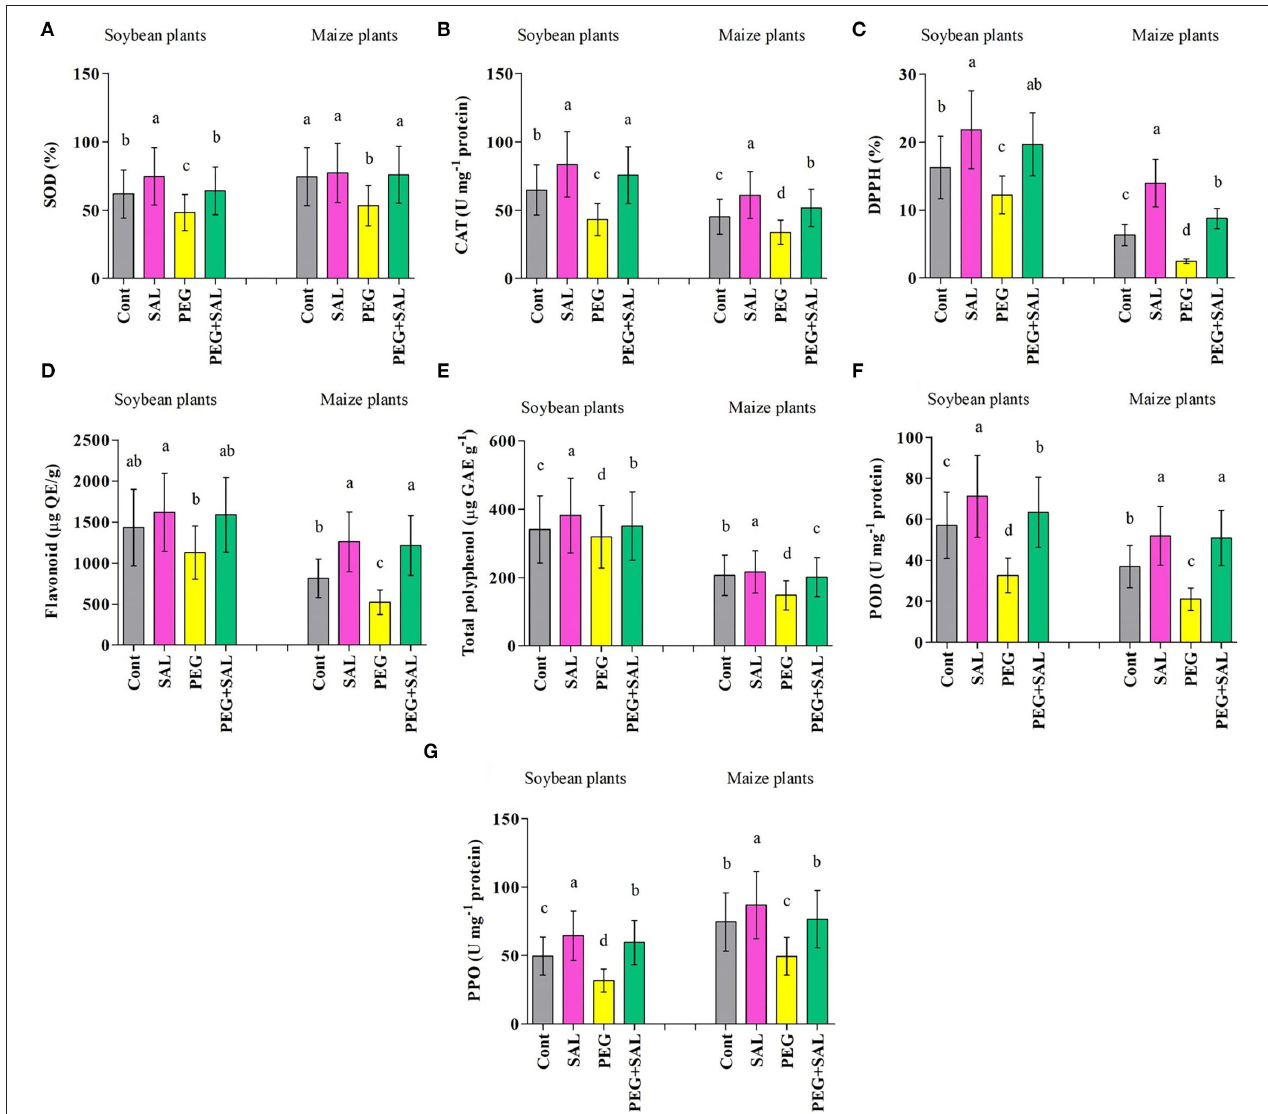
FIGURE 6 | Effect of salvianolic acid application on antioxidant content “SOD (A) ; CAT (B) ; DPPH (C) ; Flavonoids (D) ; Total polyphenol (E) ; POD (F) ; PPO (G) ” of soybean and maize leaves grown under normal and stress conditions 8 days post-treatment. Treatments: Cont (control), SAL (0.1 µ M salvianolic acid), SAL (1 µ M salvianolic acid), PEG (25% polyethylene glycol), SAL (0.1 µ M salvianolic acid) + PEG (25% polyethylene glycol), and SAL (1 µ M salvianolic acid) + PEG (25% polyethylene glycol). Values show the mean ± SE ( n = 6) and significant differences at p < 0.05 (Tukey’s test). Bars with different lowercase letters are significantly different from each